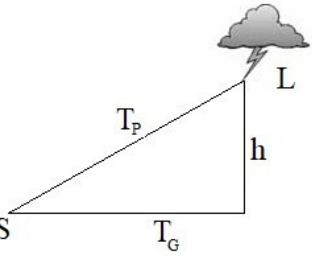
Figure 2. The LINET time delay scheme associated with IC discharges in the pseudo-3D algorithm. The time delay is related to the travel path used to estimate the height of the flash; L =